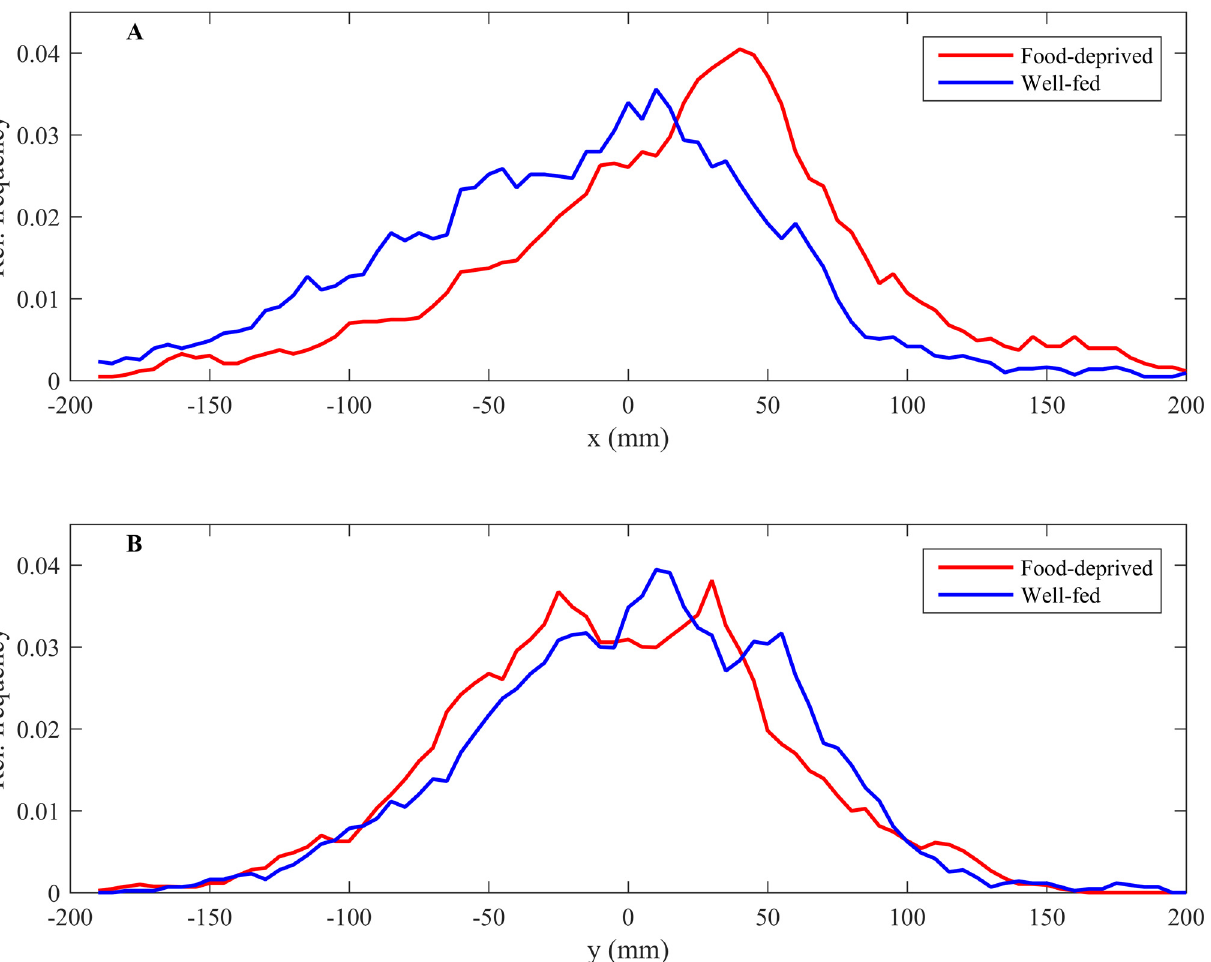
Fig 3. The relative frequency that food-deprived (red lines) and well-fed (blue lines) fish occupied different x - (A) or y -coordinates (B) relative to the group centroid (at